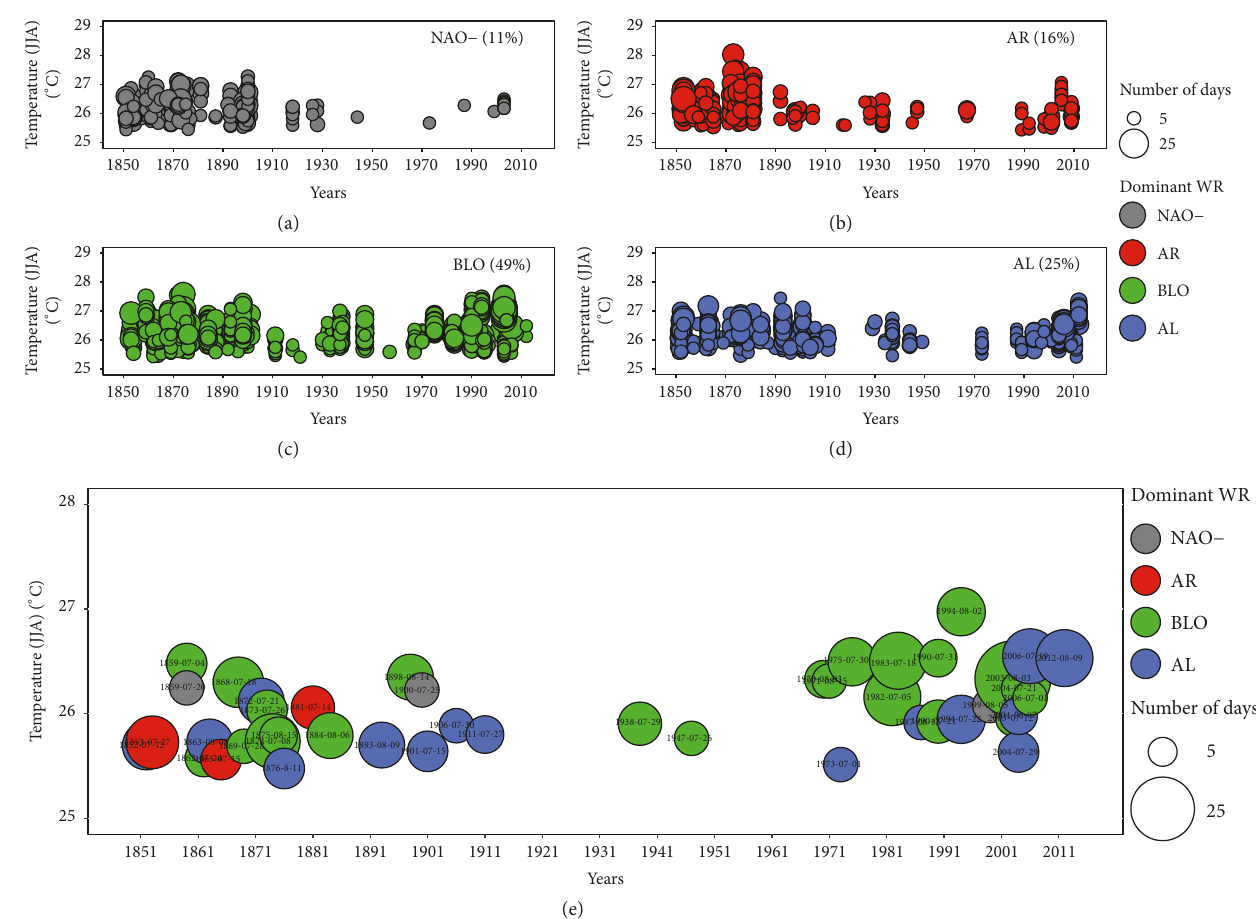
Figure 5: Dominant weather regimes during summer heatwave events. In (a)–(d), summer heatwave events (95th percentile) for all the members and (e) EM (circles with stars) of 20CR data, 1851–2014. Colors correspond to the dominant weather regime in each event, temperature ( 𝑦 -axis) and years ( 𝑥 -axis). Circle sizes depend on the event duration by number of days, the larger the longer duration.